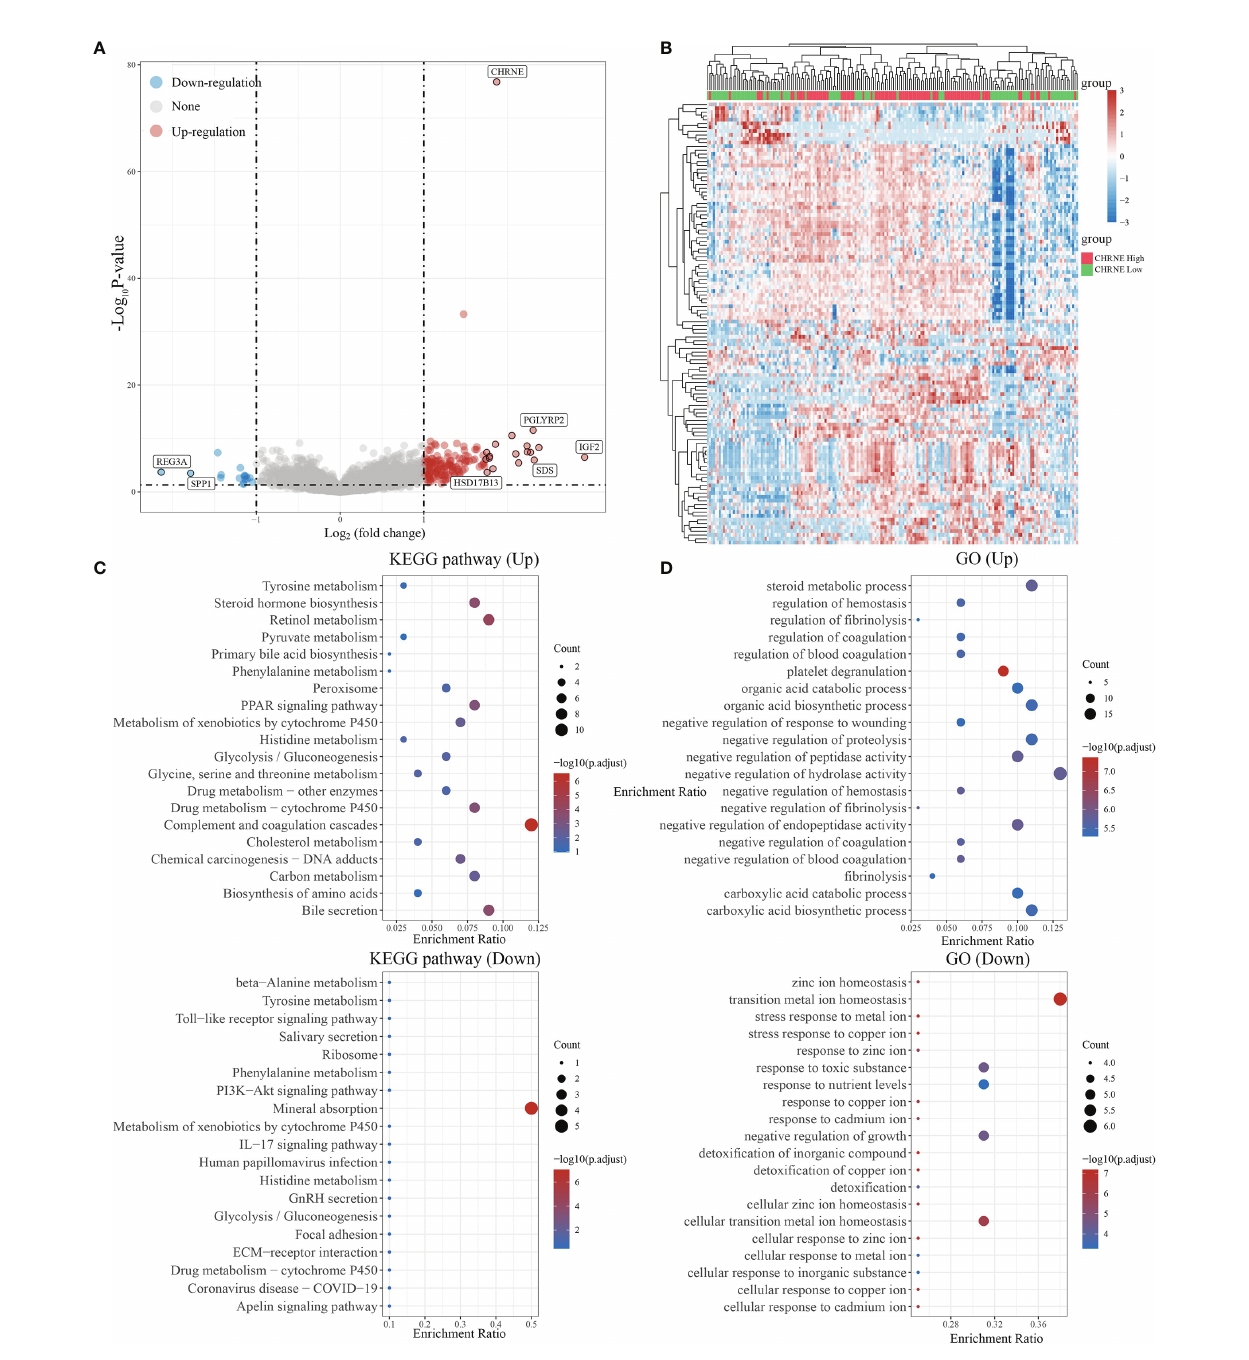
FIGURE 6 | Differential expression and enrichment analysis of high and low CHRNE expression groups. (A) The volcano plot shows the differential gene expression of CHRNE high expression group and CHRNE low expression group was drawn with fold-change values and adjusted P. (B) Differential gene expression showed by heatmap (only 50 genes were displayed because of the large quantity of the genes); (C, D) KEGG and GO analysis showed the upregulated/downregulated pathways of the CHRNE high expression group compared with the low expression group. When P <0.05 or FDR <0.05 is considered to be enriched to a meaningful